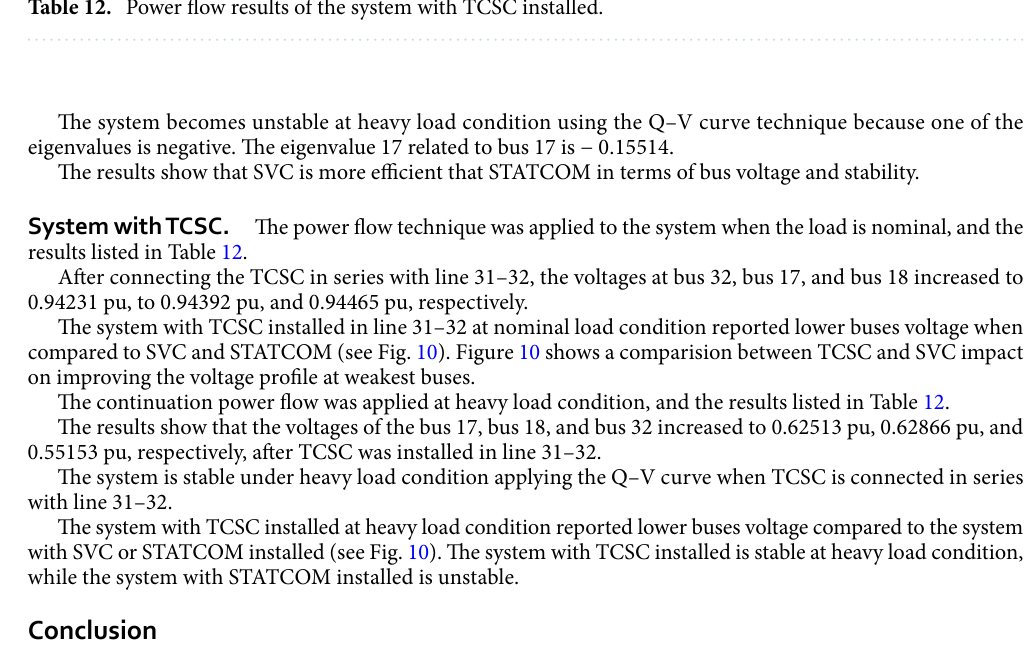
Table 12. Power flow results of the system with TCSC